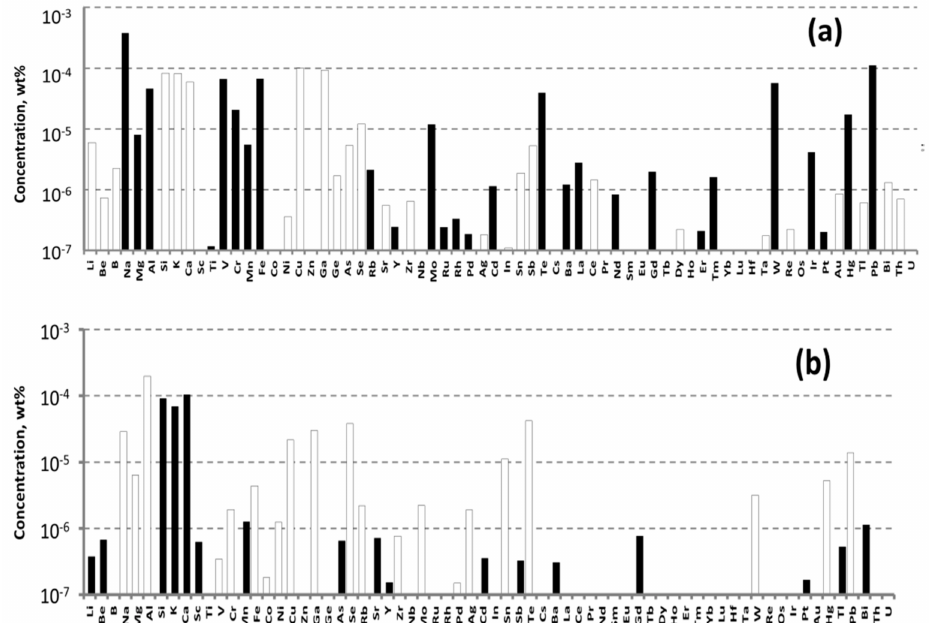
Figure 3. Impurities concentrations determined in the commercial ( a ) and purified ( b ) ZnO by ICP-MS